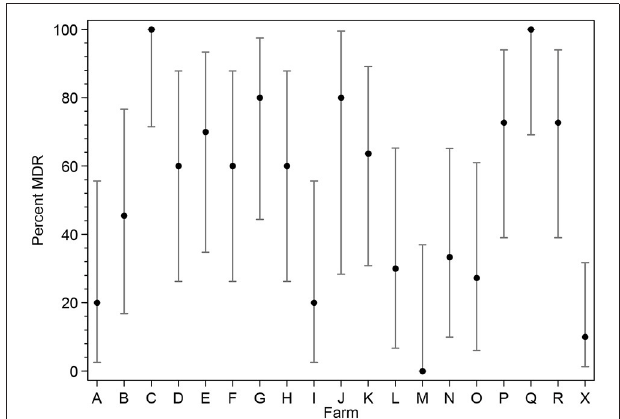
FIGURE 2 | Point estimates and 95% confidence interval for the percent of commensal E. coli colonies expressing MDR phenotype within each of 19 Australian pig herds.